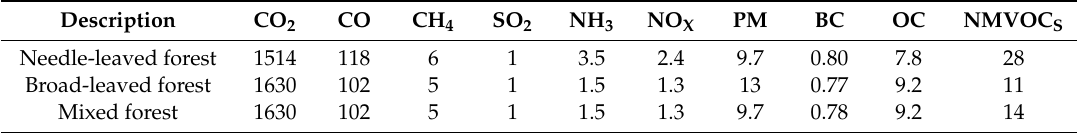
Table 2. Emission factors assigned to forest fires in each of the forest types from the MCD12Q1 data (unit: g kg − 1 ).